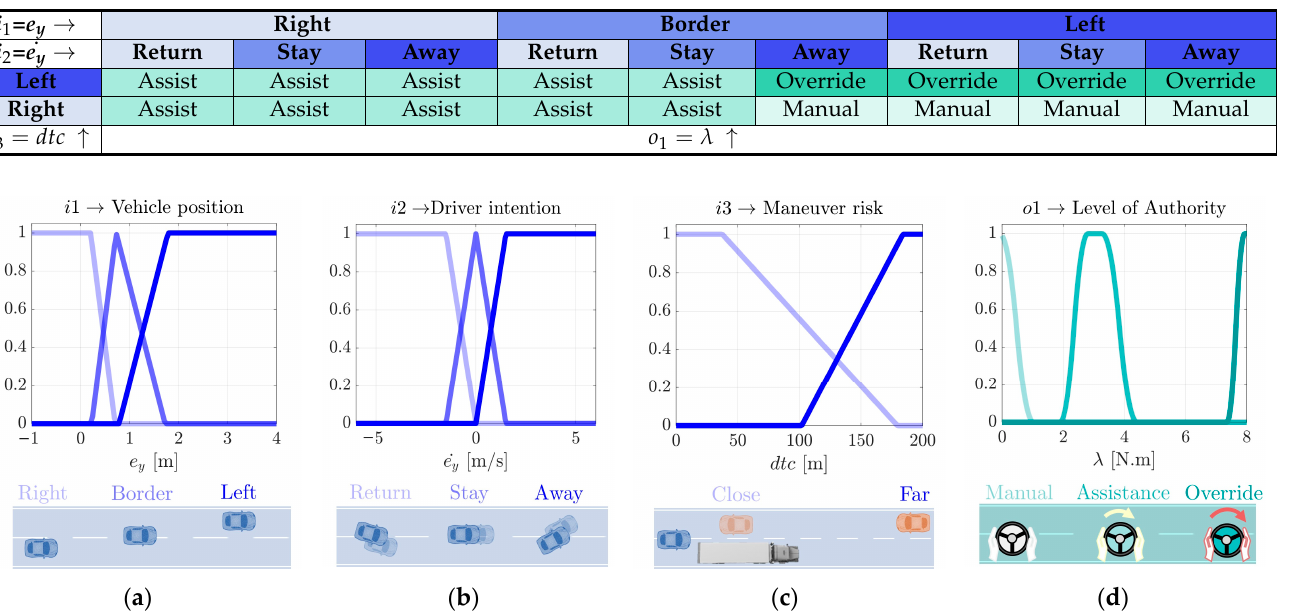
Table 1. The FL rules of the arbitration system for SC mode, for the cooperative overtaking maneuver. The rules include three inputs: the lateral error ( i 1 ), the lateral error derivative ( i 2 ), and the distance to collision ( i 3 ), and also the output ( o 1 ) which is the level of steering assistance or torque intensity, which is called the haptic authority ( λ ).